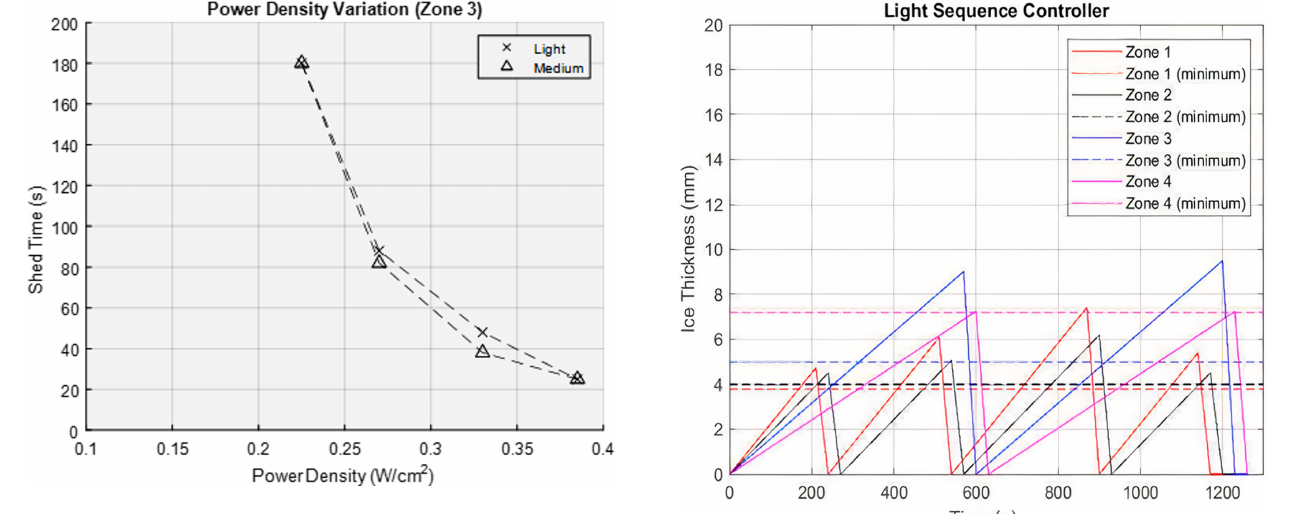
Figure 25. Power density variation shedding times for heater zone 3.